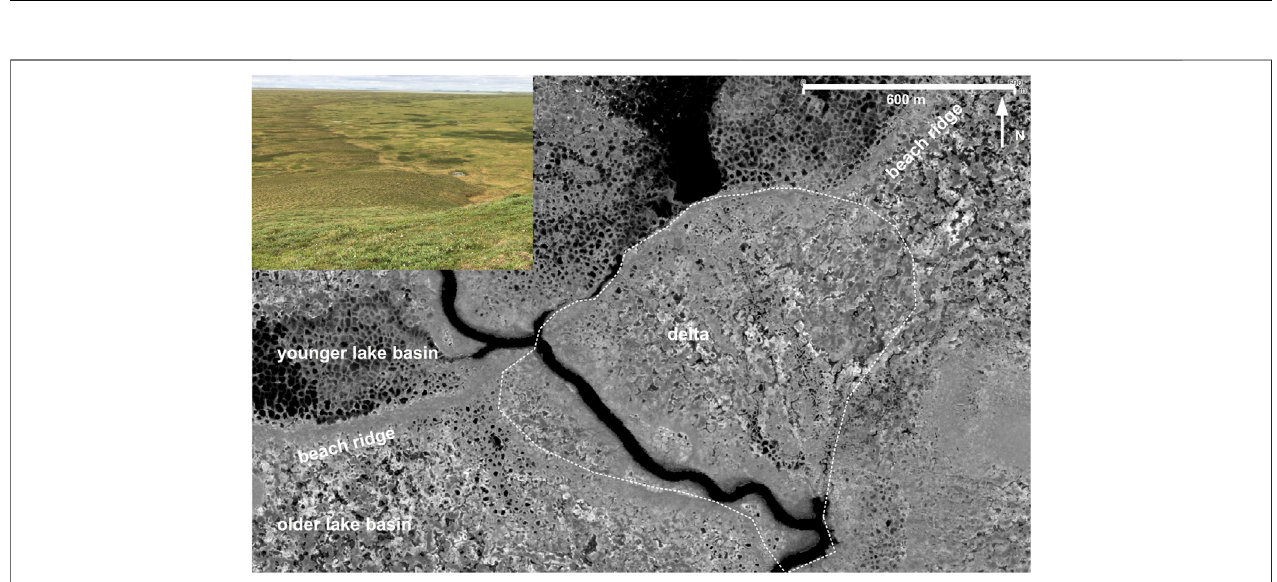
FIGURE 6 | Border between two lake basins with different age and surface micro-relief. The elevation difference is less than 1 m. The border of the younger lake is marked by a low ridge. In the center a former river delta. Inset: beach ridge of the same lake seen from point 1 in Figure 4 ; in the lower left corner the beach ridge is overridden by a thaw slump debris lobe, photo J. vanHuissteden. Location of the image frame: see Figure 4 at nr 4. WorldView © 2019 MAXAR.